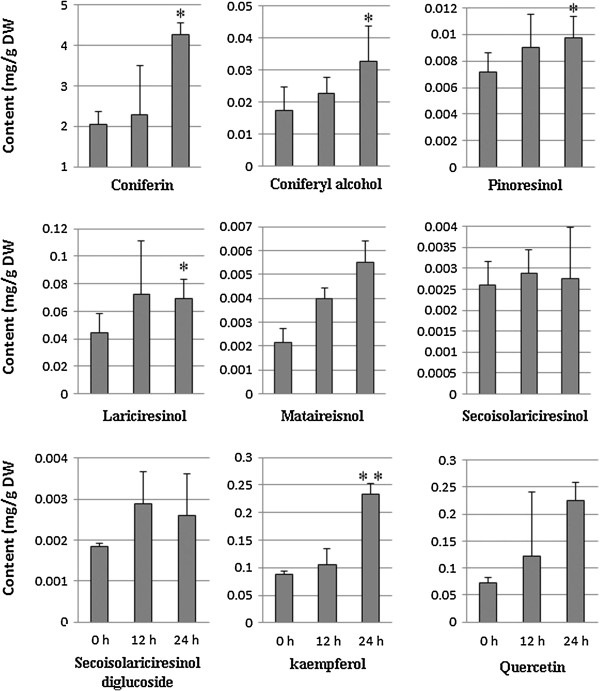
MeJA-induced changes in the phenlypropenoids accumulation during I. indigotica hairy roots culture period. The accumulation of metabolites in I. indigotica hairy roots after MeJA treatment for 12 h and 24 h was compared to control. Error bars show the standard deviations of independent strains. Asterisk indicates that difference is significant (*: p < 0.05, **: p < 0.01) compared with control.